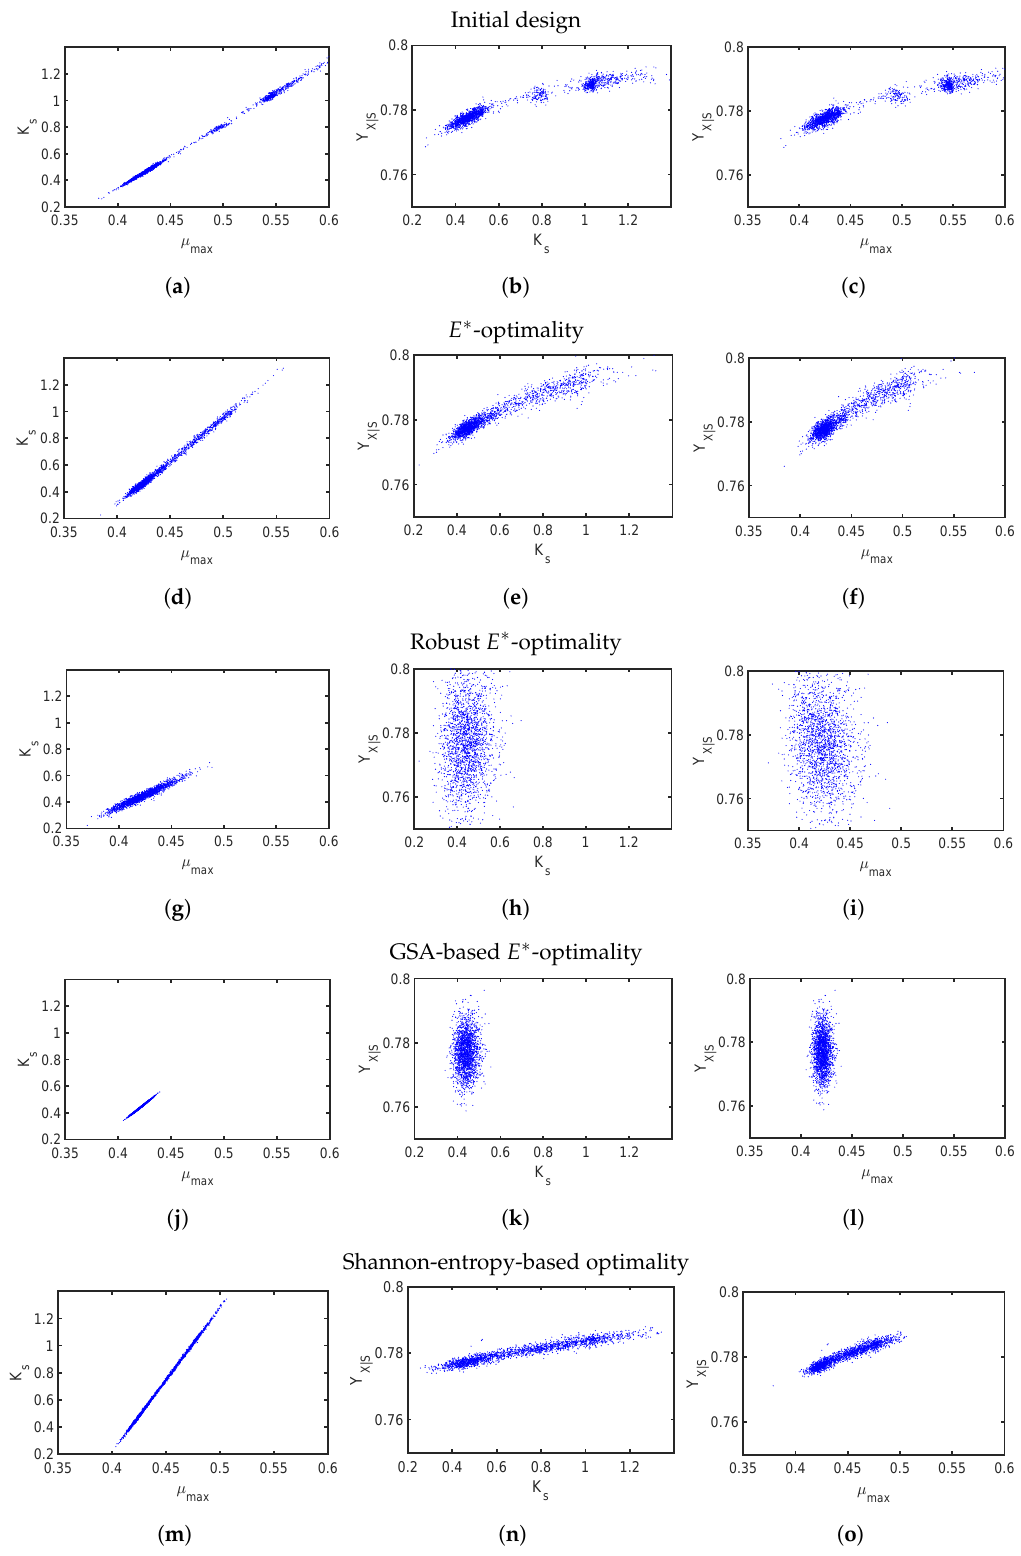
Figure 9. Performance of the experiments from initial design ( a – c ), E ∗ -optimality ( d – f ), robust E ∗ -optimality ( g – i ), GSA-based E ∗ -optimality ( j – l ), and Shannon-entropy-based design ( m – o ), where scatter plots are used to present the confidence region for the estimated parameters, which result from 2000 MC